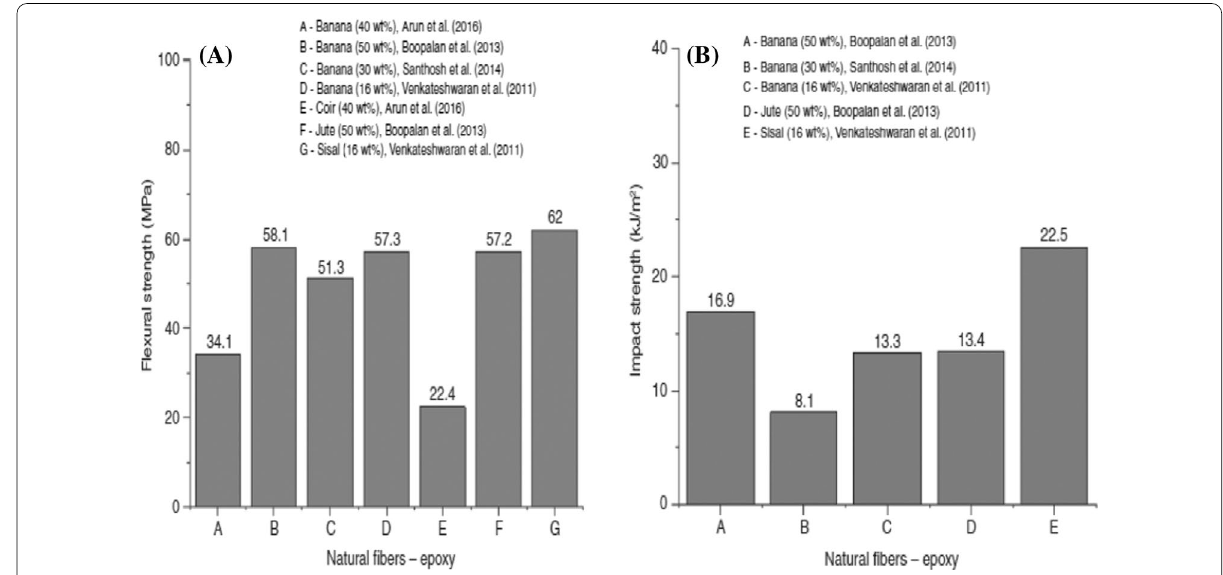
Fig. 8 a , b Flexural and Impact strength of natural fibre-reinforced epoxy composites (Kulkarni et al.